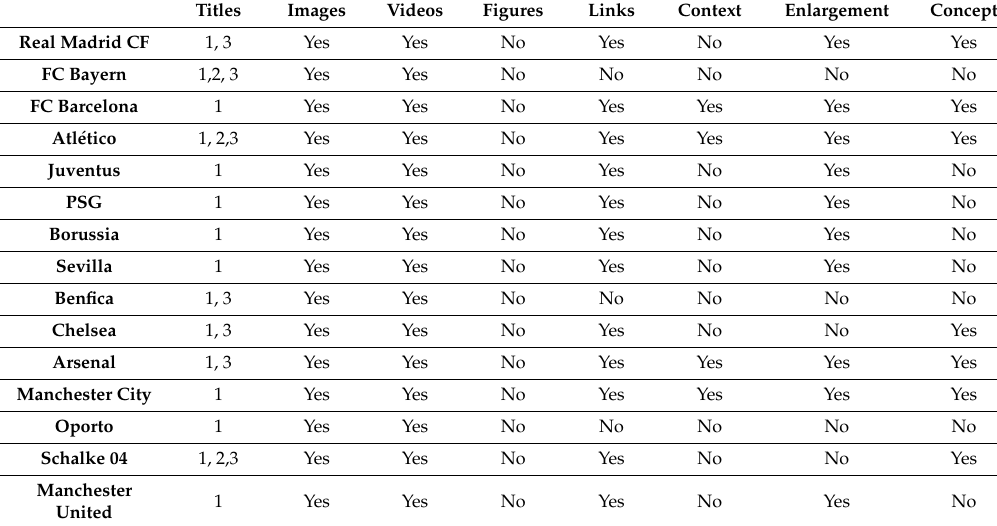
Table 5. Content design and type.